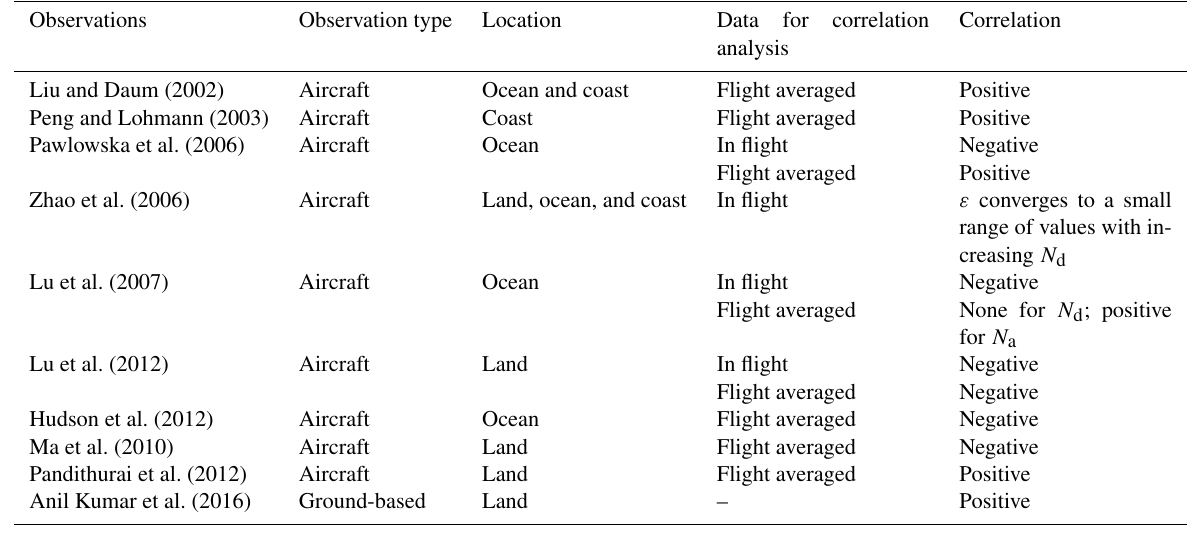
Table 1. Correlations between ε and N d ( N a ) from observation studies.